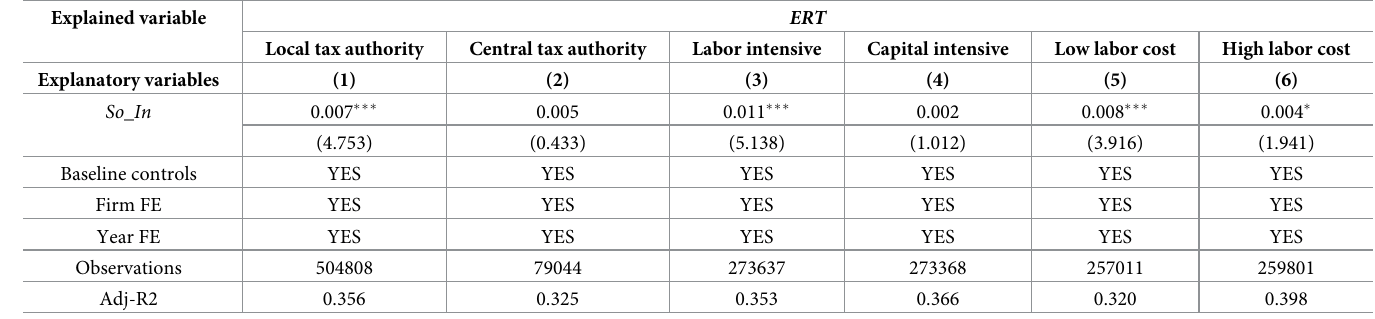
Table 9. Heterogeneous analysis. Explained